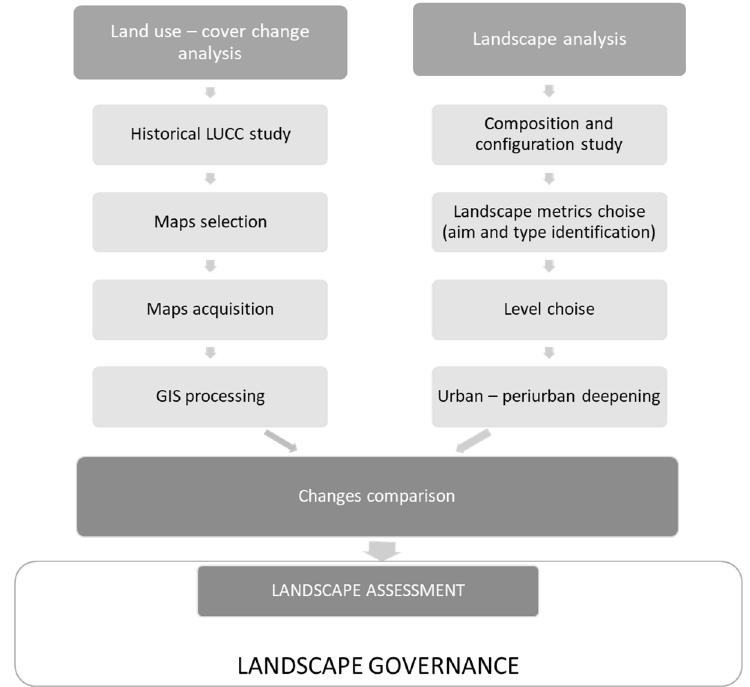
Figure 1. The framework.